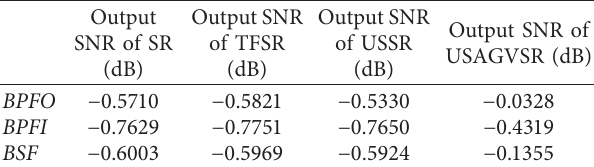
Figure 28: Signals processed by USAGVSR. Table 3: Output SNR comparison of different fault types.